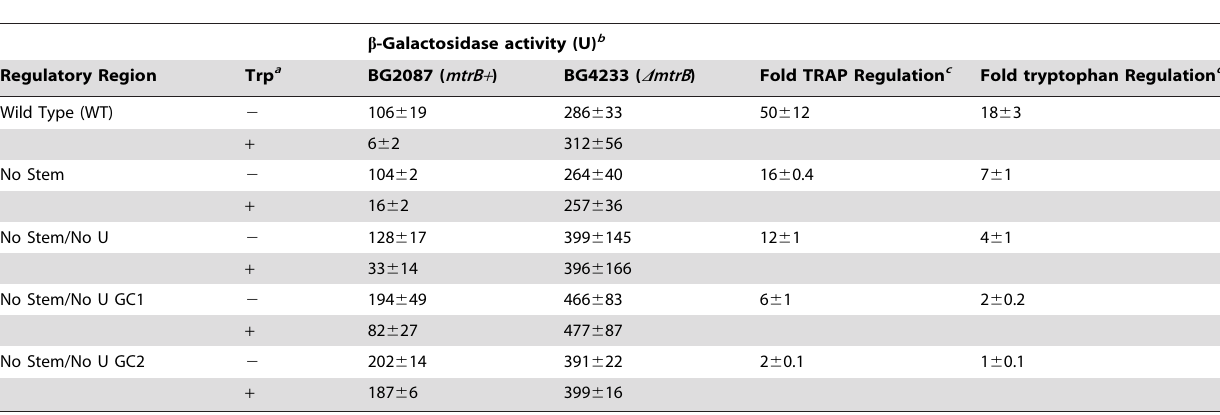
Table 2. Effects of deletions within the trp leader region on TRAP-mediated transcription termination invivo